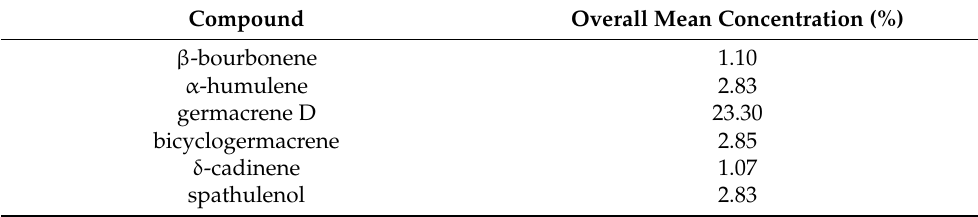
Within each column, means sharing the same letter are not significantly different. Table 2. Overall mean concentration (%) of the 6 compounds ( β -bourbonene, α -humulene, germa- crene D, bicyclogermacrene, δ -cadinene, and spathulenol) where there was no significant difference among the harvest stages.